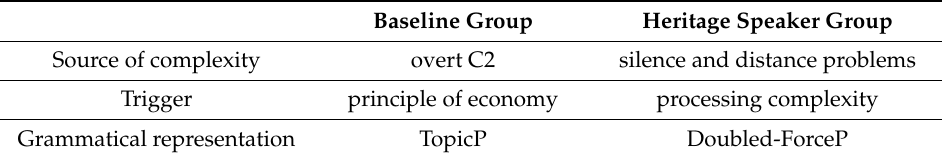
Table 7. Multiple representations account of